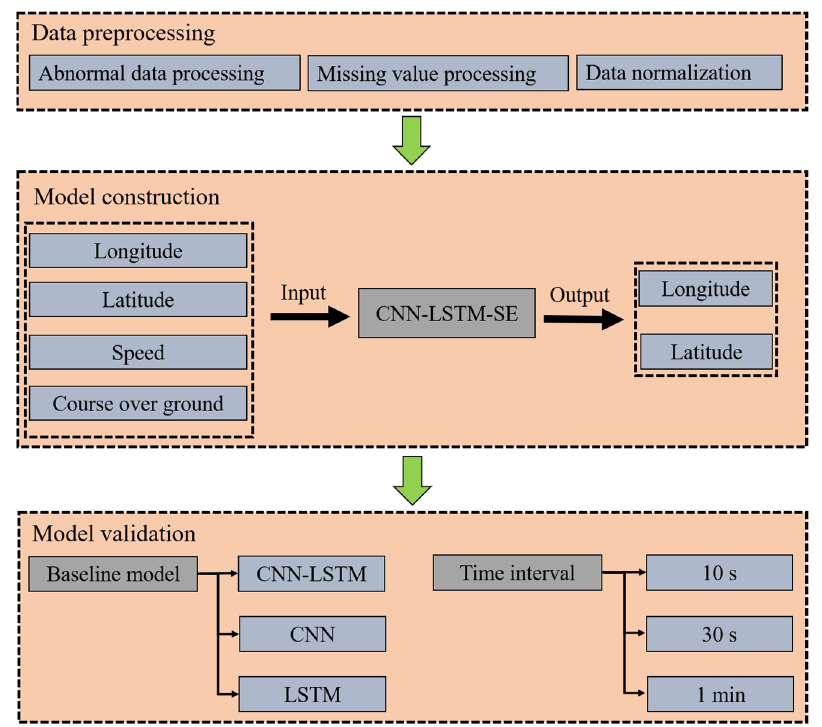
Figure 1. The research framework of the ship trajectory prediction method.